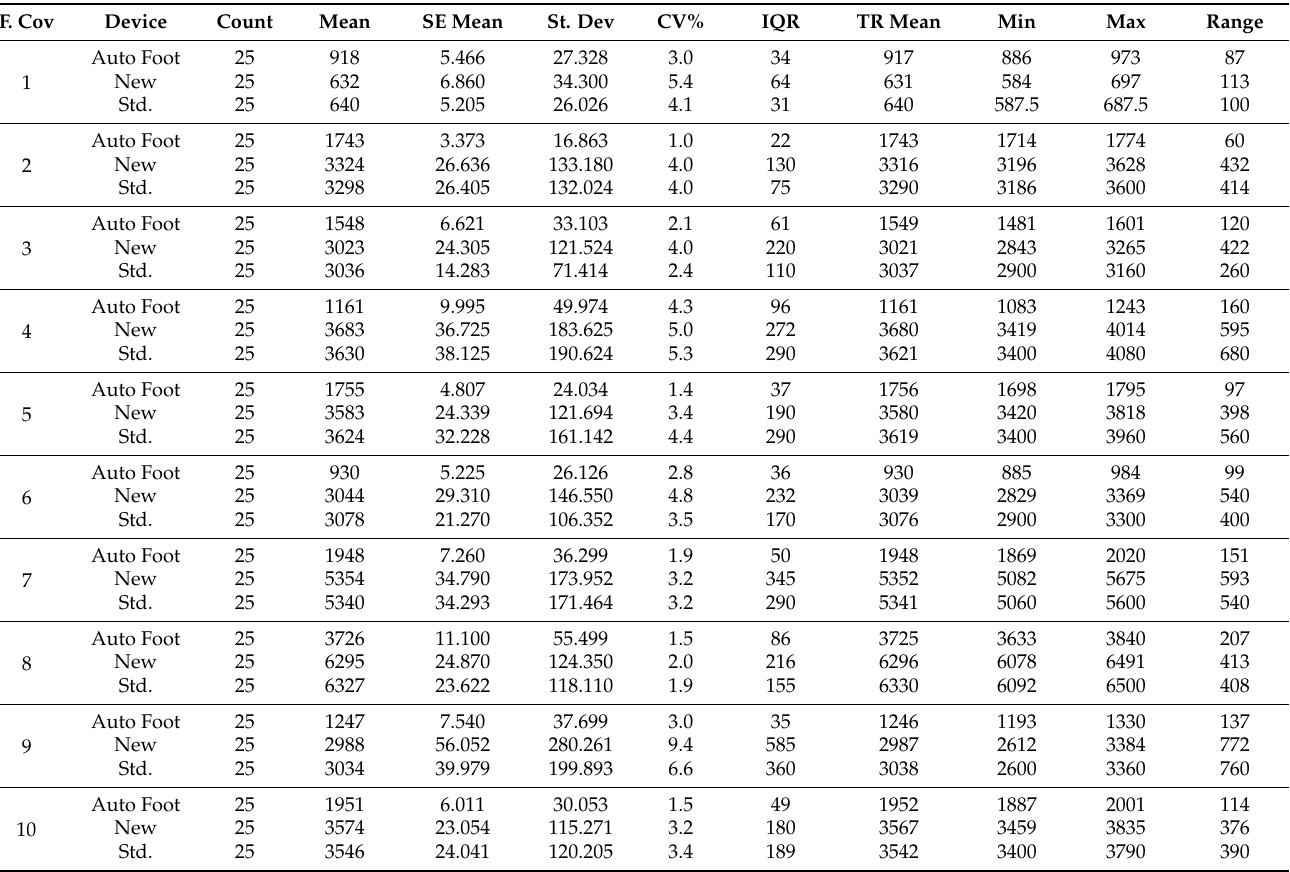
Table 5. Descriptive statistics of floorcoverings samples for highest valleys checked on standard, new, and automated foot.